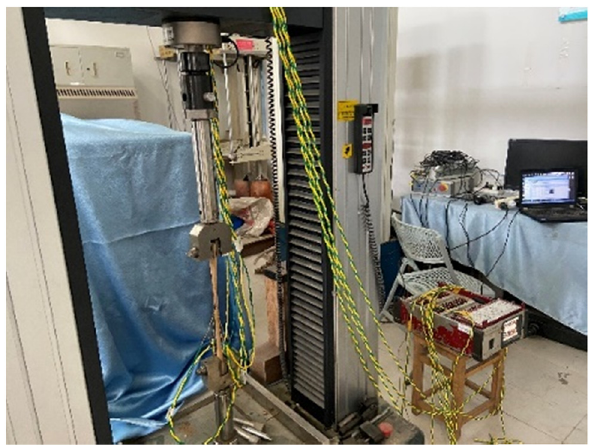
Figure 1: The experimental equipment.